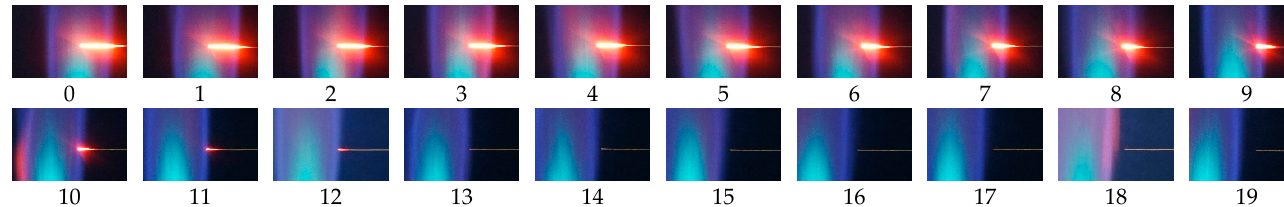
Δ = 0–19 mm under Δ = 65 mm. The numbers below each image represent the values of 2a 1a